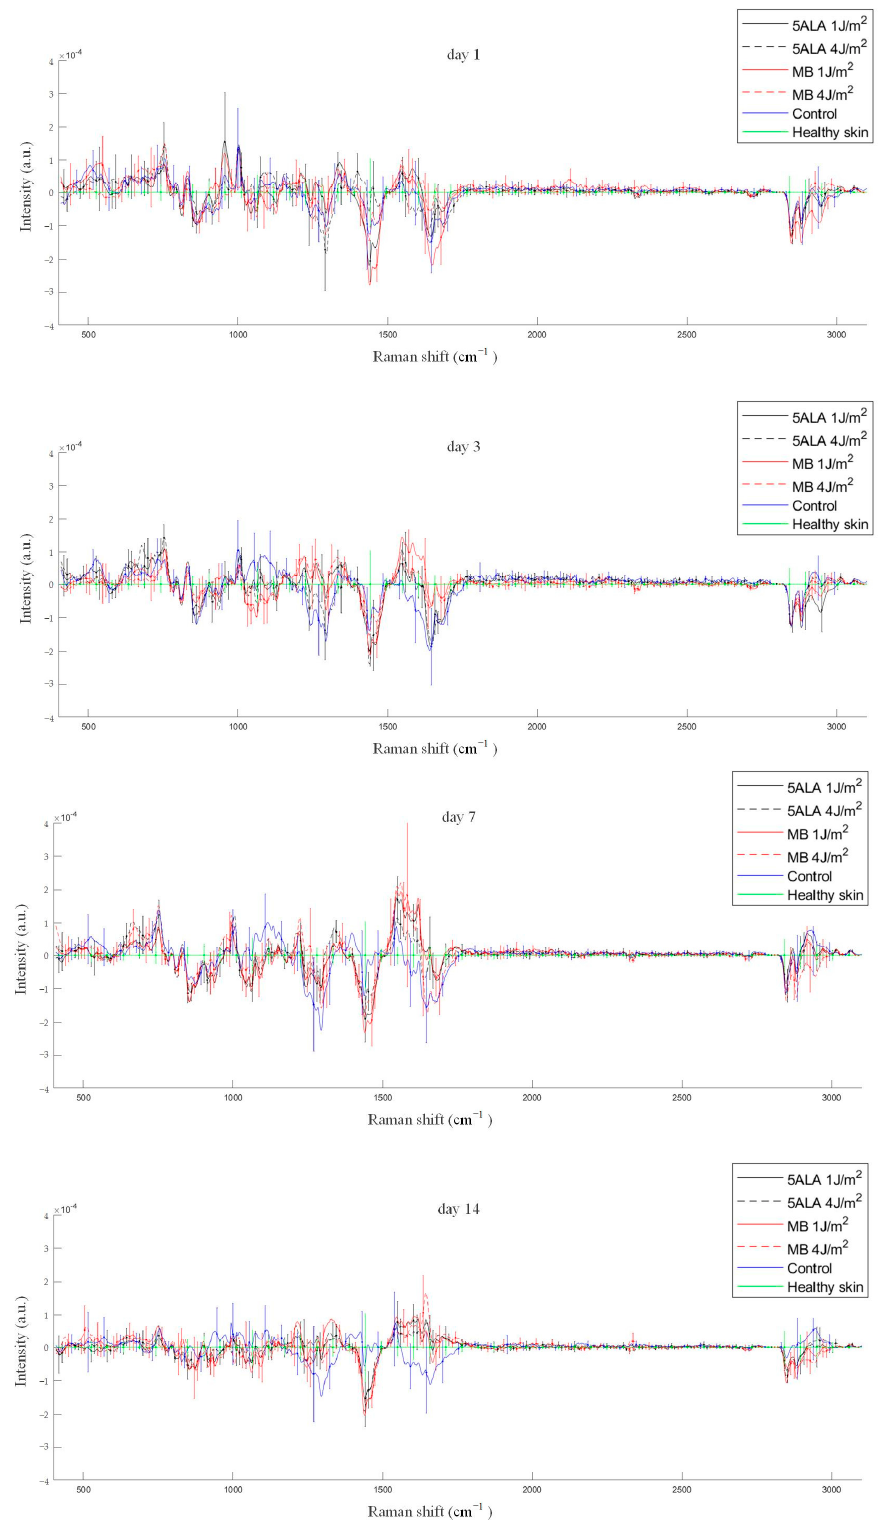
Figure 11. Differences between the wound Raman spectra of all groups subtracting the healthy skin mean Raman spectrum. The Raman spectra are presented in terms of mean ± StD values. Black line—5ALA 1 J/cm 2 , black dashed line—5ALA 4 J/cm 2 , red line—MB 1 J/cm 2 , red dashed line—MB 4 J/cm 2 , blue line—control, green line—healthy skin (the number of processed Raman spectra was equal to 30 for each group).